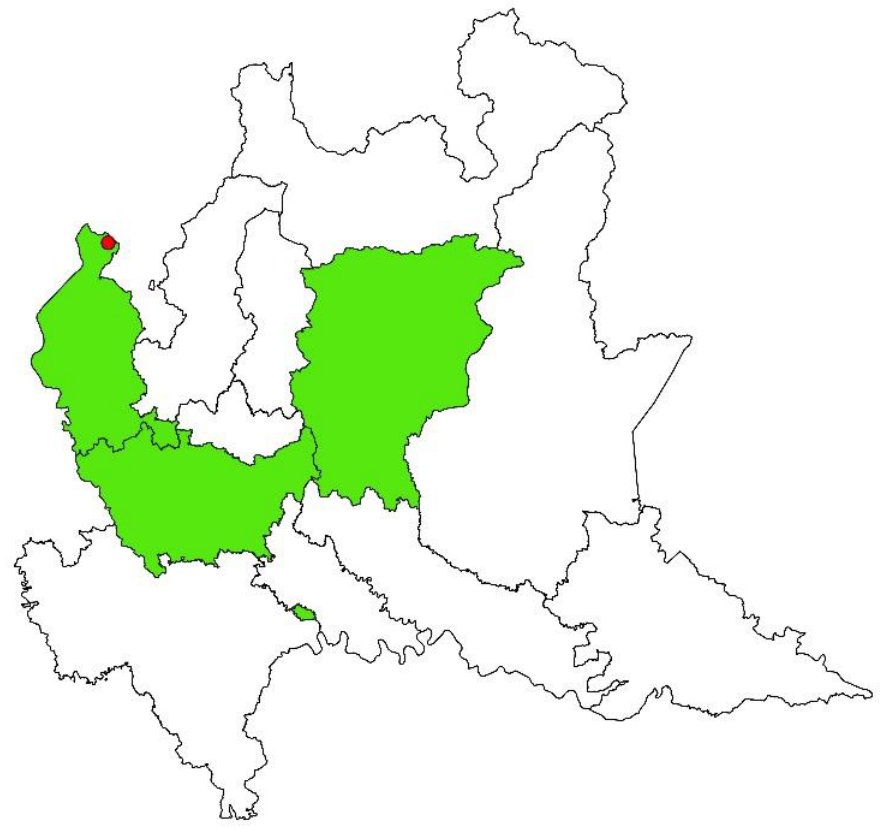
Figure4. Geographicalallocationofthesignificantcluster(inred)of Neosporacaninum highprevalencein Figure 4. Geographical allocation of the significant cluster (in red) of Neospora caninum high goatfarmsinnorthernItaly. Greenrepresentsthestudiedarea(Varese, Milano, and Bergamo provinces). prevalence in goat farms in northern Italy. Green represents the studied area (Varese, Milano, and Bergamo provinces).